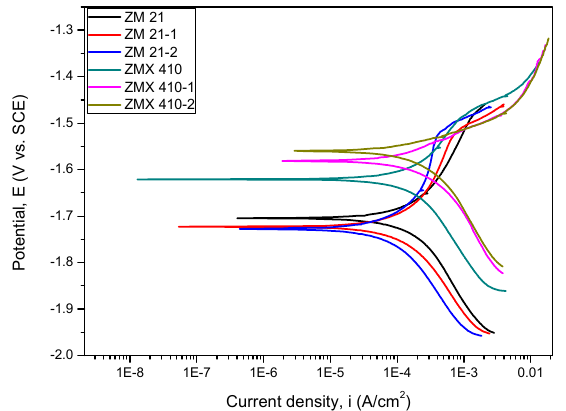
Figure 13. Open loop potential (E oc ) for all samples tested in SBF.